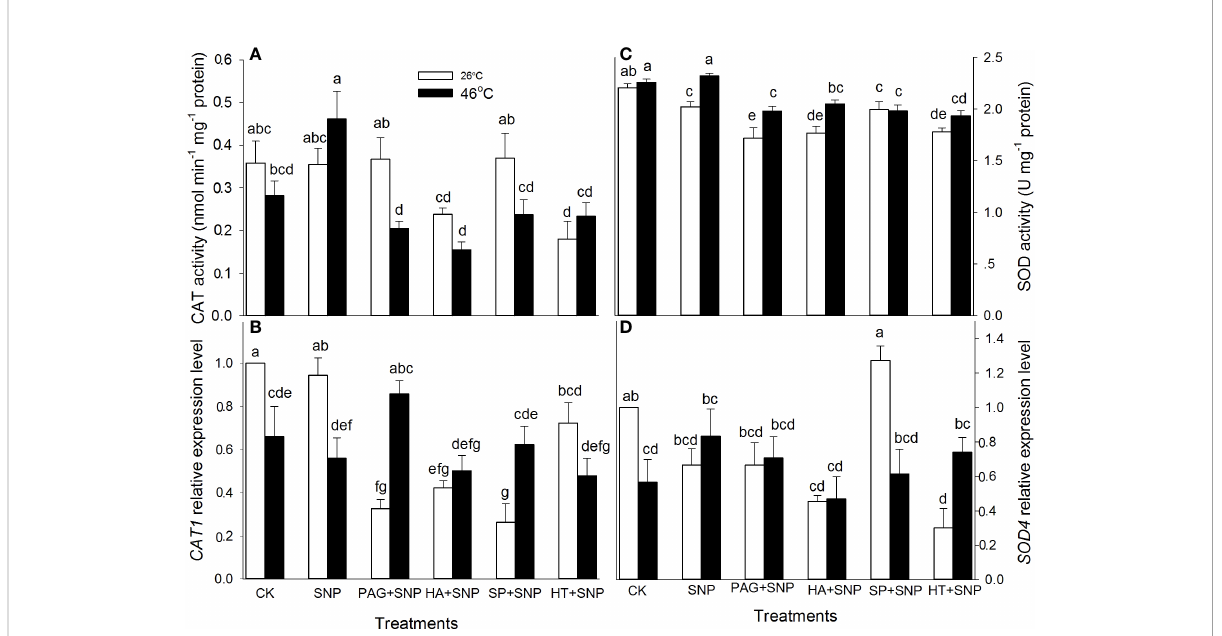
FIGURE 5 Effect of SNP alone or in combination with hydrogen sul fi de (H 2 S) inhibitors and scavengers on catalase (CAT) (A) and superoxide dismutase (SOD) (C) activities and corresponding gene expression (B, D) in maize seedlings under non-HS and HS conditions. The data had at least three biological replicates and were tested using Duncan's multiple-range test at 0.05 signi fi cant level, which denote means ± standard error (SE). The bars with the different letters represent signi fi cant differences, while the same letters represent no signi fi cant